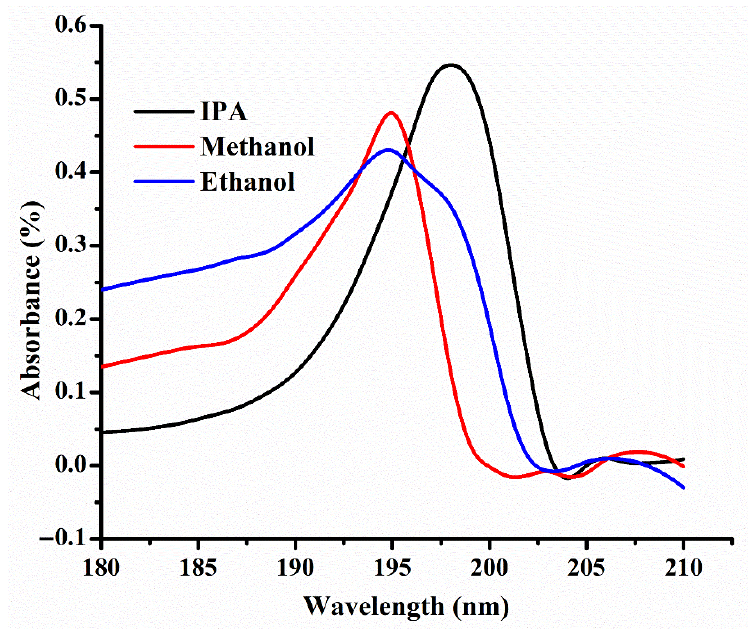
Figure 10. Sensing response of the sensor in the presence of various